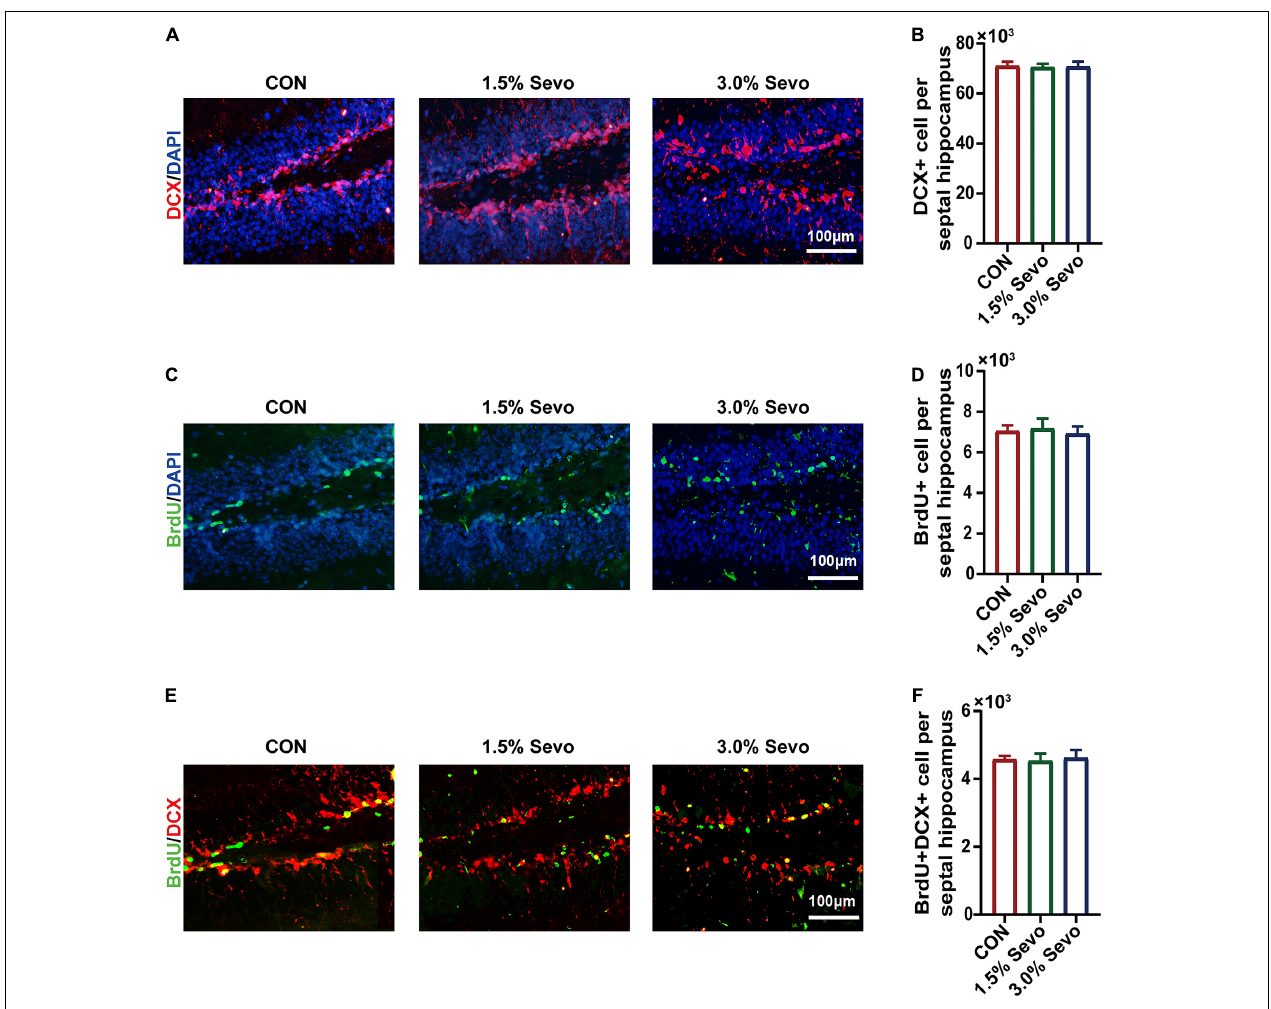
FIGURE 4 | Sevoflurane exposure does not induce the inhibition of DCX+, BrdU+ and BrdU+DCX+ cells in the hippocampi of adult mice. (A) Representative immunofluorescence images of DCX+ cells in adult mice. (B) Quantitative analysis of DCX+ cells in adult mice. (C) Representative immunofluorescence images of BrdU+ cells in adult mice. (D) Quantitative analysis of BrdU+ cells in adult mice. (E) Representative immunofluorescence images of BrdU+DCX+ cells in adult mice. (F) Quantitative analysis of BrdU+DCX+ cells in adult mice. Values are the mean ± S.E.M ( n = 8/group). BrdU, 5-Bromodeoxyuridine; DCX, doublecortin; CON, control group; 1.5% Sevo, 1.5% sevoflurane group; 3.0% Sevo, 3.0% sevoflurane group.